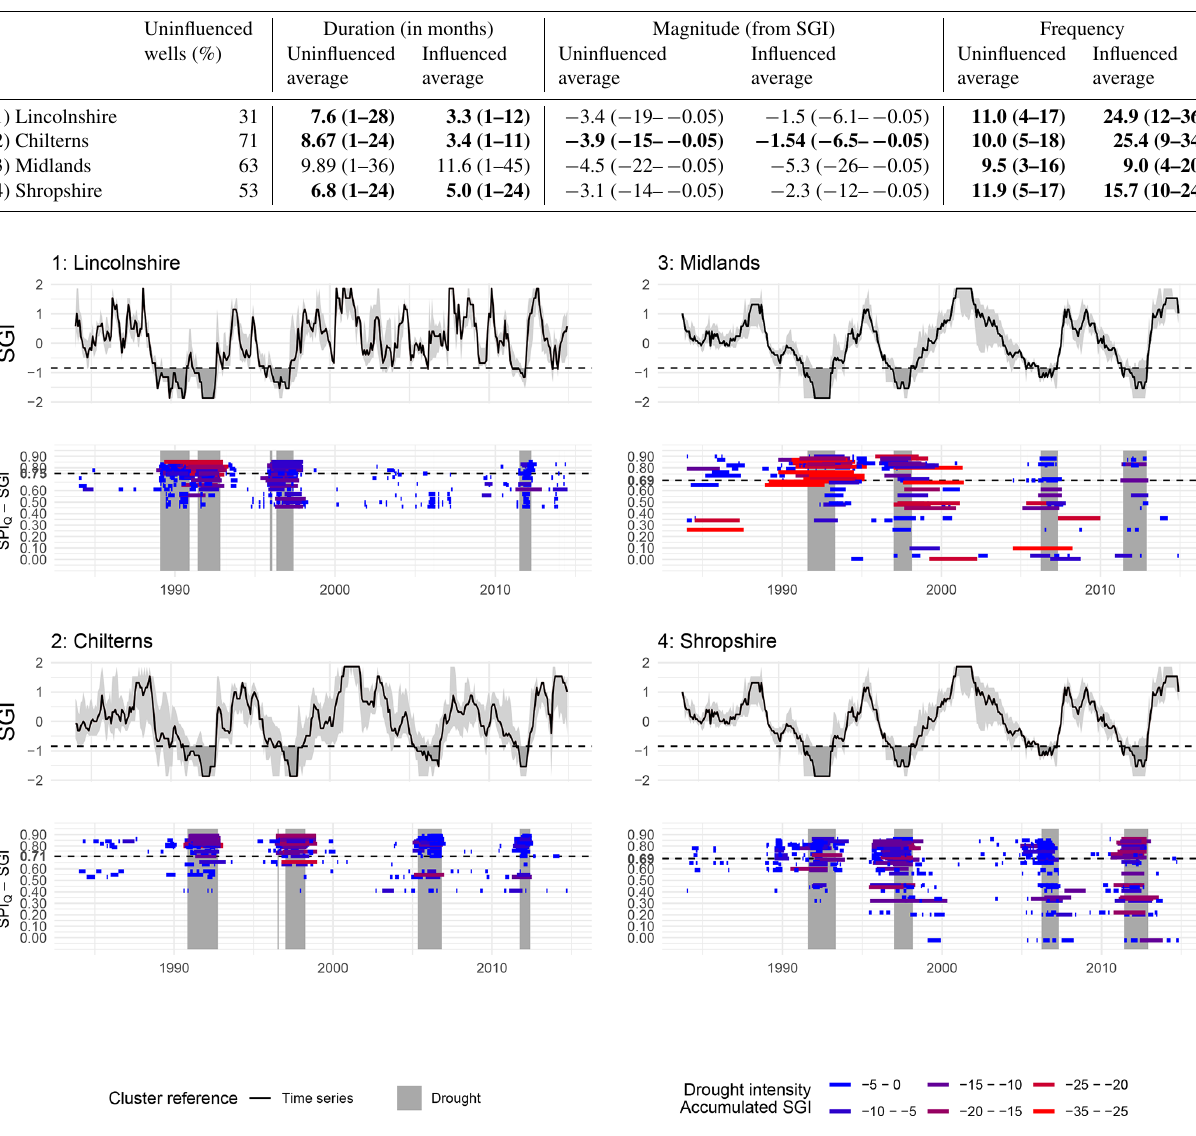
Figure 2. Drought occurrence, duration, and magnitude shown for all four water management units: 1 – Lincolnshire, 2 – Chilterns, 3 – Midlands, and 4 – Shropshire. The top panel shows the SGI hydrograph of the reference cluster mean based on reference sites (see Fig. 1 for the locations of these clusters). The range of reference clusters is coloured in grey. The dotted line represents the drought threshold for the cluster mean, with shaded areas for the reference drought events. These reference drought events are also shown in long grey panels in the lower plot that shows the individual droughts as found in monitoring sites in each water management unit. The length of coloured bars indicates the drought duration, and the colour represents drought magnitude of each drought in a blue–red scale for accumulated